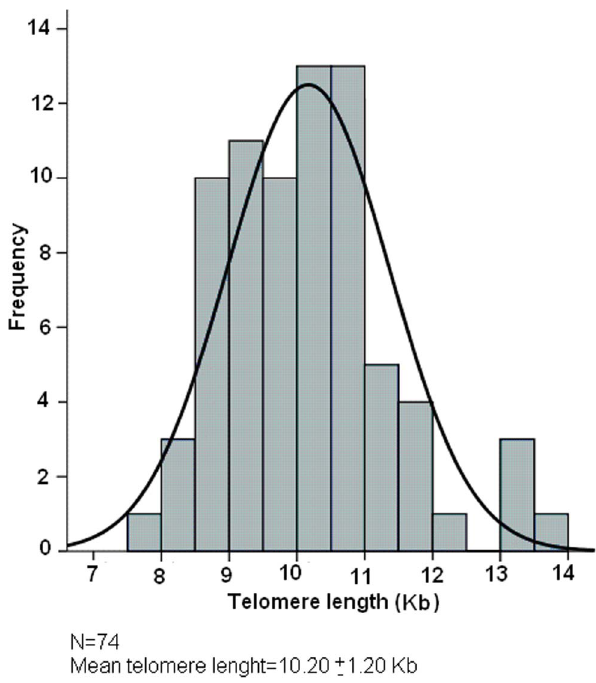
Figure 1. Telomere length distribution in the newborn population (N=74). As observed, TRF length is heterogeneous from birth.